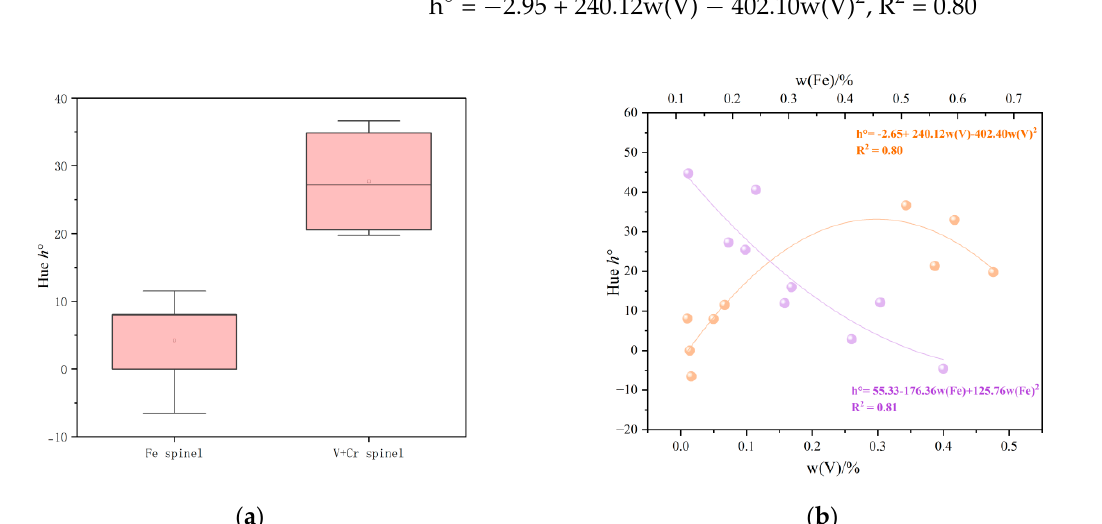
Figure 10. ( a ) Distribution range of spinel hue angle h ◦ ( b ) Relationship between hue angle h ◦ and